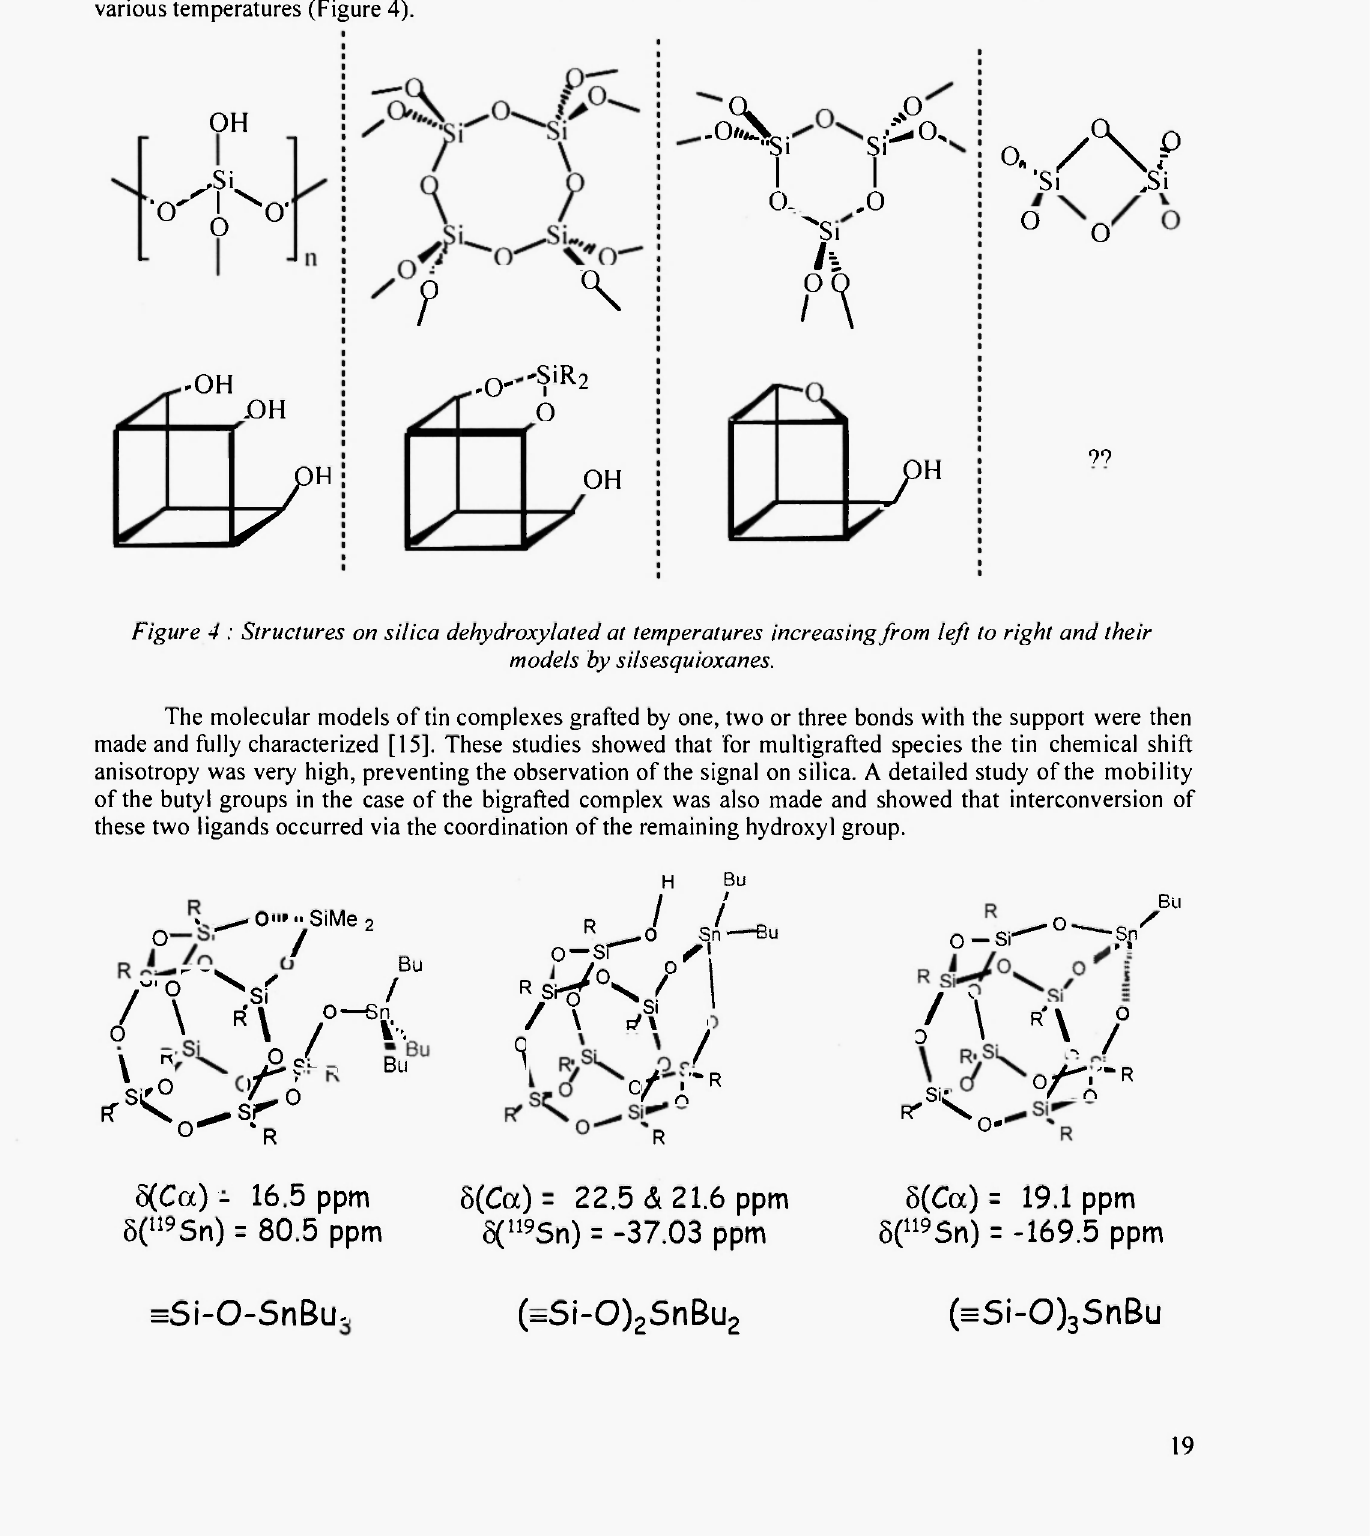
Figure 3 : Decomposition products of sSi-O-SnBus (left) synthesized on silica dehydroxylated at 500 (a) and (200 °C (b) and of mSi-0-GeBu 3 synthesized on silica dehydroxylated at 500°C (right)